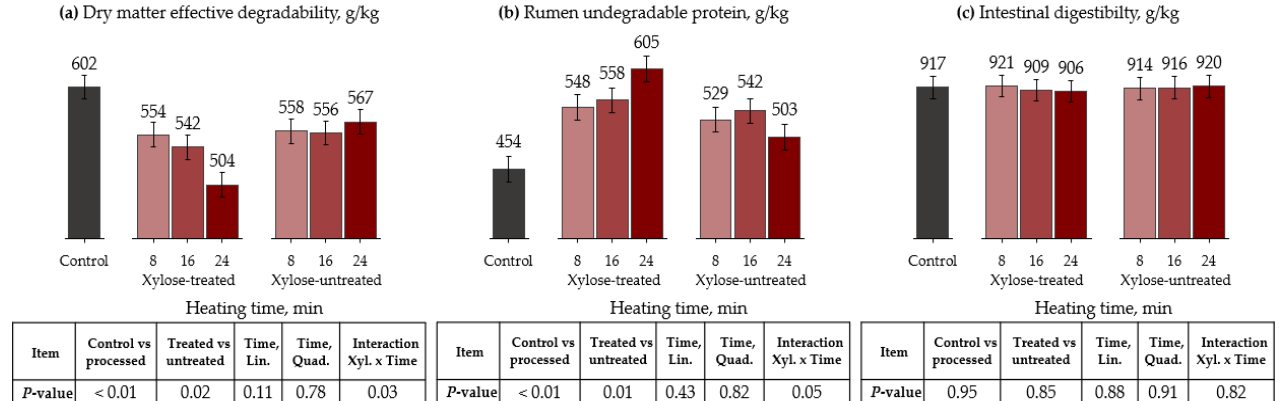
Figure 1. Effects of autoclave heating and xylose treatment on dry matter effective degradability ( a , ED), rumen undegradable protein ( b , RUP), and intestinal digestibility ( c ) of peanut meal. ED = A + [B × kd/(kd + kp) × e -kt ] [31]; RUP = B × [kp/(kp + kd)], where A is the water-soluble fraction, g/kg; B is the potentially degradable water-insoluble fraction, g/kg; kd is the degradation rate of fraction b, h −1 ; t is time, h; and kp is the rumen passage rate (k) of 0.074 h −1 [32]. Regarding protein kinetics, the control had a greater fraction A and lower RUP than processed treatments ( p < 0.01). Xylose-untreated samples had a greater fraction A than xylose-treated samples ( p = 0.01). Furthermore, treatments without xylose had a lower fraction B than those with xylose. We observed a tendency toward greater kd for the xy- lose-treated group for than the xylose-untreated group ( p = 0.08). The control had lower RUP than the processed treatments ( p < 0.01). Moreover, an interaction showed that RUP increased as the processing time increased only for treatments with xylose ( p = 0.05). Com- pared with the control, the RUP proportion increased by 21, 23, and 33% when 8, 16, and 24 minutes of autoclaving were applied to the xylose-treated peanut meal, respectively. Processing methods did not affect protein ID compared to the control ( p > 0.82). 3.2. Conventional Oven The ruminal degradation parameters of DM and CP, as well as protein ID, are pre- sented in Table 5 and Figure 2, for the conventional oven treatment. The control treatment had greater DM fraction A and ED than the processed treatments ( p < 0.01). Moreover, ED responded quadratically as heating time increased ( p < 0.01). On the other hand, the pro- cessing methods did not affect the fraction B and kd of DM ( p > 0.82). For CP kinetics, the control had a greater fraction A than the processed treatments ( p < 0.01). Likewise, processing methods did not affect the fraction B and kd of the protein ( p > 0.24). The control had lower RUP compared with the processed treatments ( p < 0.01). Furthermore, heating time had a quadratic effect on RUP, with the highest values reached at 60 min for both xylose-treated and -untreated peanut meals ( p = 0.02). The processing methods affected ID, reducing it compared with the control ( p = 0.02). Moreover, there was an interaction between xylose and heating time, where an increased heating time lin- early reduced the ID only for xylose-untreated peanut meal ( p = 0.01).